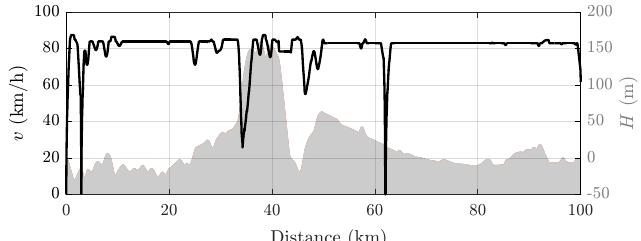
Figure 5. Drive cycle velocity and height profile for the VECTO regional long-haul drive cycle